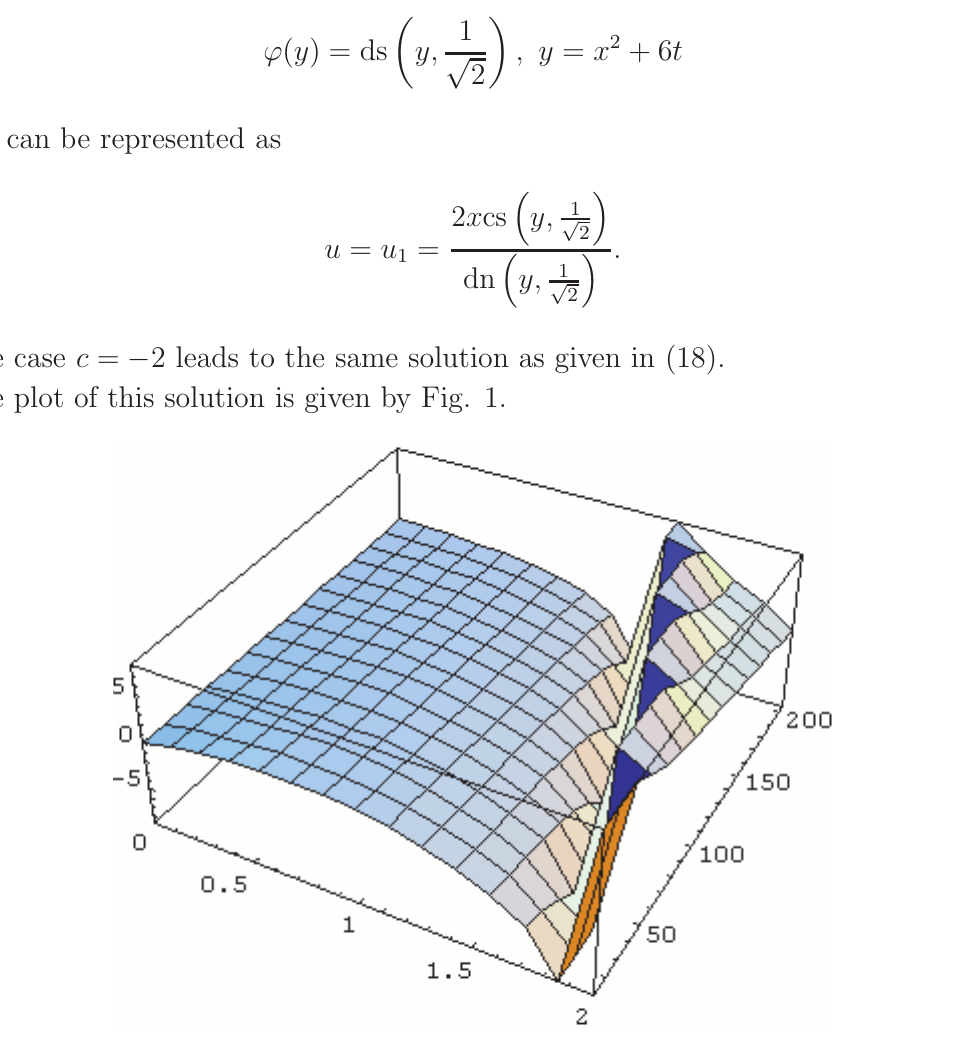
Fig. 1 Solution (18) for equation (10), 0 < t